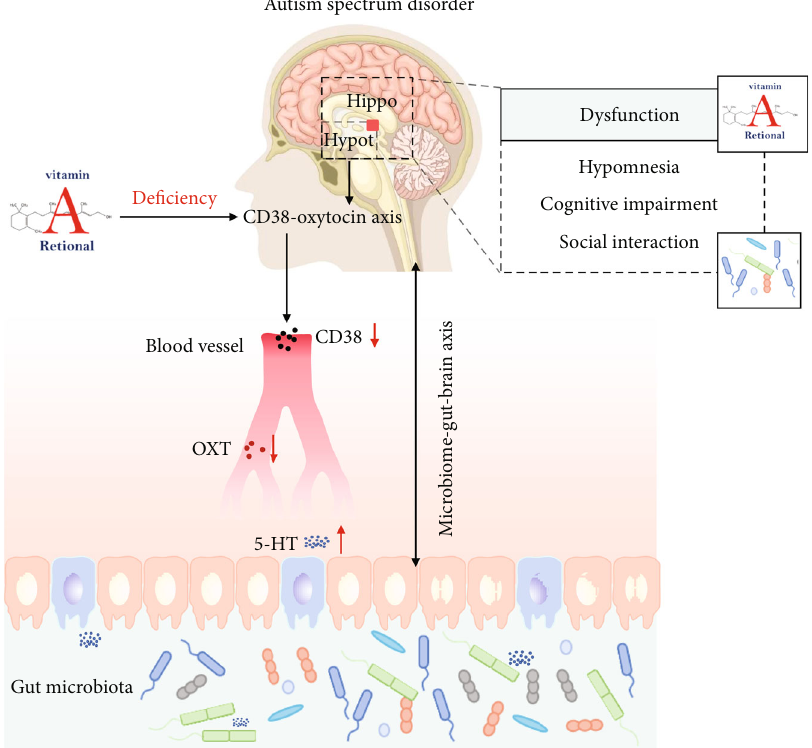
Figure 1: The multiple e ff ects of VA in ASD. In the nervous system, VAD can lead to amnesia, cognitive impairment, and social impairment. In the GI system, VAD a ff ects GI bacteria, causing associated symptoms. In the immune system, VAD can lead to a decrease in serum 5-HT and OXT through the CD38-OXT pathway. In addition, the nervous system and the GI system can interact with each other by modulating the microbiota-gut-brain